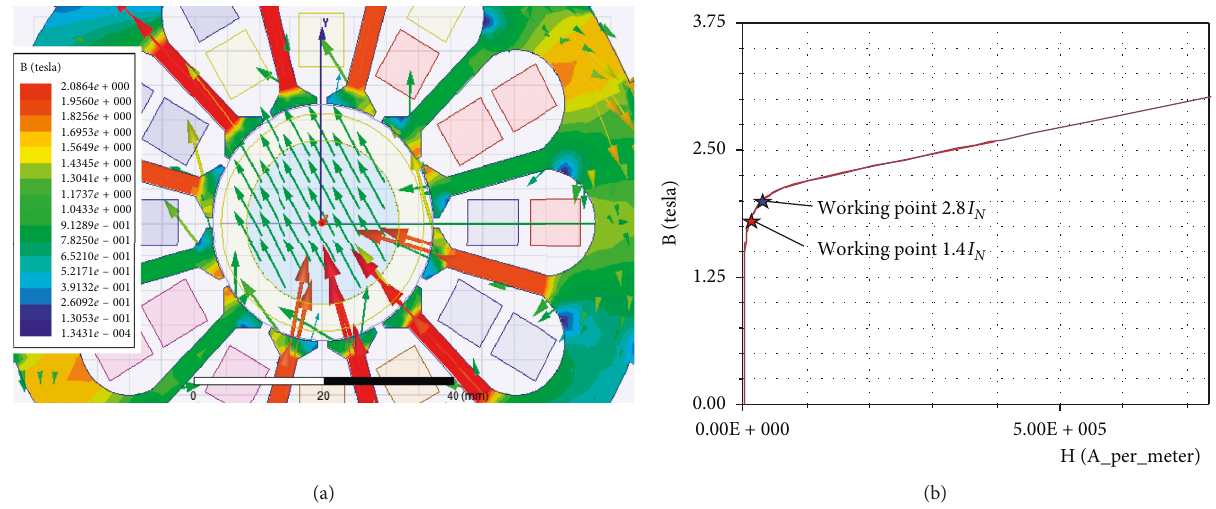
Figure 8: Magnetic saturation condition of the stator iron. (a) Distribution of flux density for I